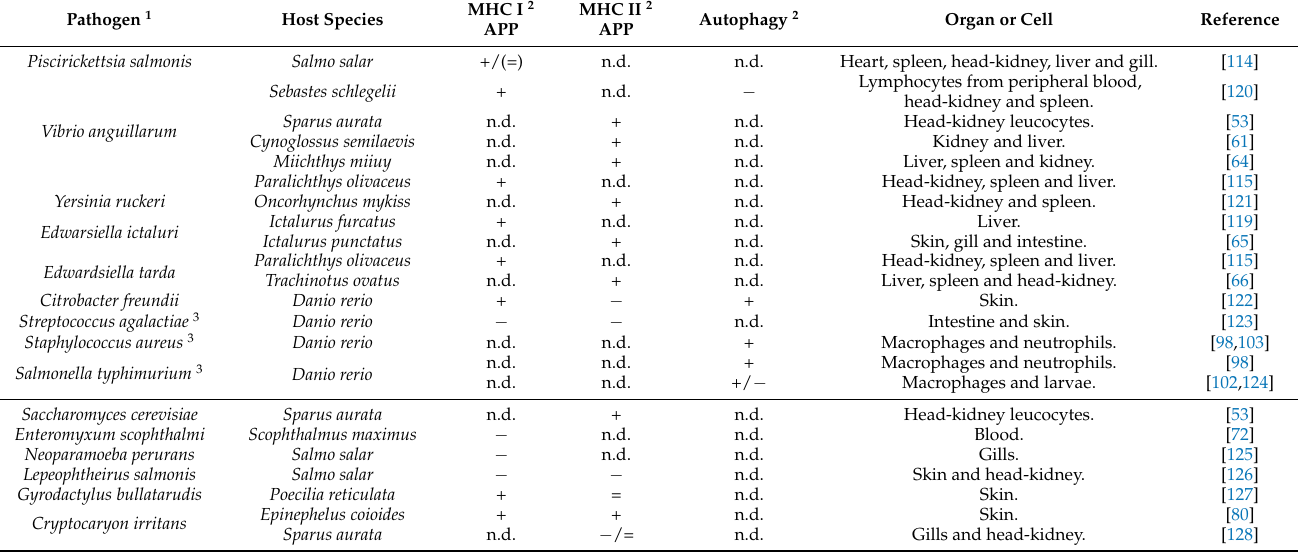
Table 2. Modulation of expression of genes involved in antigen processing and presentation (APP) MHC class I and II pathways and autophagy during infection of teleost fish species by bacteria or eukaryote